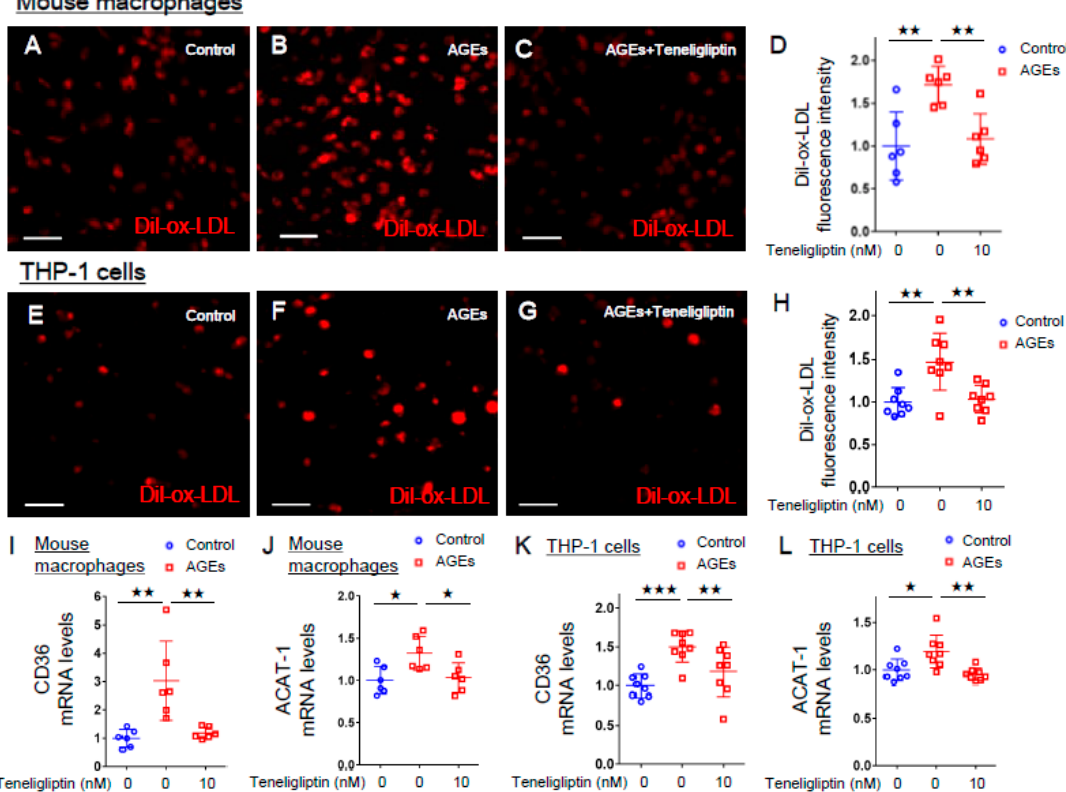
Figure 2. Effects of teneligliptin on ox-LDL uptake, CD36 and ACAT-1 gene expression in AGE-exposed mouse macrophages and THP-1 cells. ( A – C , E – G ) Representative immunofluorescent staining images in mouse peritoneal macrophages ( A – C ) and THP-1 cells ( E – G ). Dil-ox-LDL staining cells were in red. Scale bars represent 50 µm for A-C and 100 µm for E-G. ( D , H ) Fluorescence intensity of Dil-ox-LDL per area. ( I–L ) Gene expression levels of CD36 ( I , K ) and ACAT-1 ( J , L ) in mouse macrophages and THP-1 cells. ( A–C,D,I,J ) number = 6 for each group. ( E–G,H,K,L ) number = 8 for each group. (D,H-L) are normalized to the control levels. *** p < 0.005, ** p < 0.01, * p < 0.05.